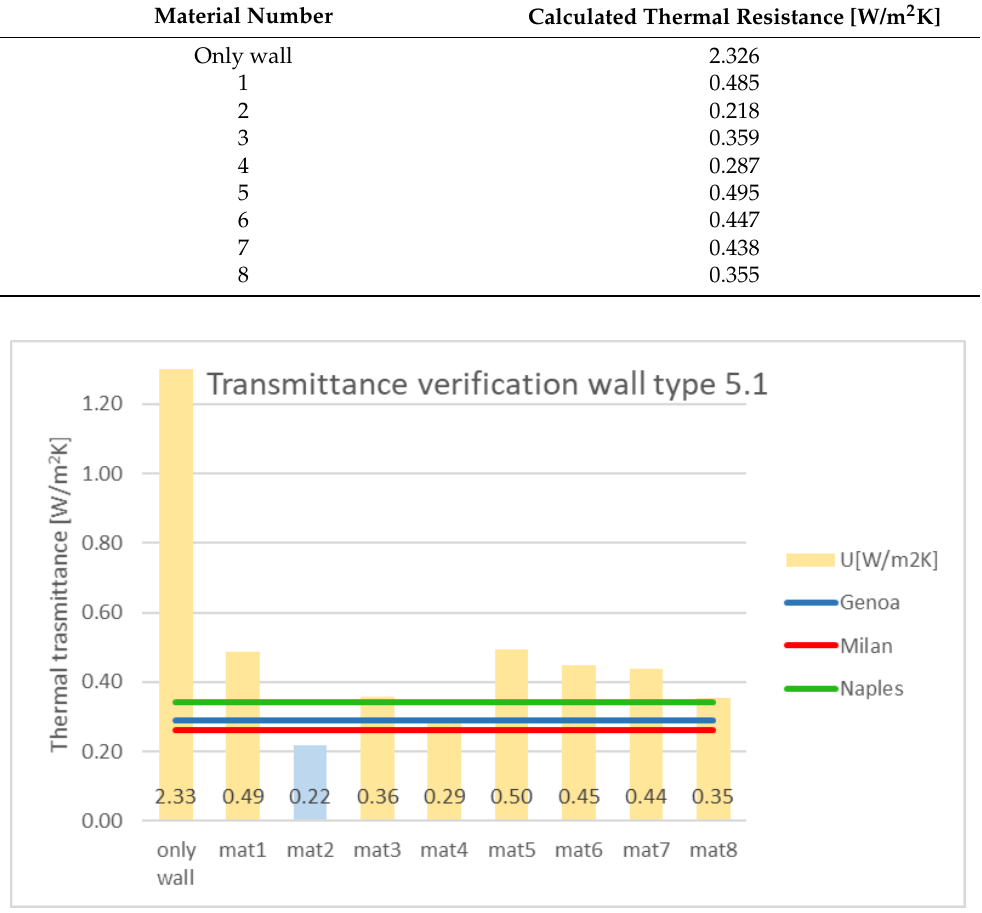
Figure A15. Wall type 5.2: stratigraphy with thicknesses and conductivities for the different layers. The numbers start from the outside.